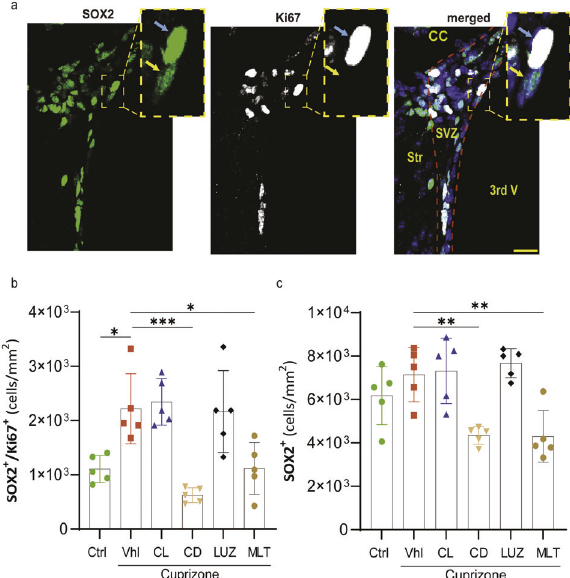
Fig. 4 Quanti fi cation of NSPC responses to demyelination and treatment in the SVZ. a Fluorescent staining of the NSPC marker SOX2, the proliferation marker Ki67, and DAPI. The blue arrow indicates proliferative SOX2, and yellow shows quiescent NSPCs. b Quanti fi cation of the number of proliferative NSPCs (SOX2 + / Ki67 + ). c Quanti fi cation of the number of NSPCs (SOX2 + ), which included both quiescent and proliferative NSPCs. All quanti fi cations were performed in the SVZ region on 25 μ m-thick sections ( n = 5 mice/group; 3 slides per mouse). Signi fi cance is indicated by ∗ p < 0.05, ∗∗ p < 0.01, and ∗∗∗ p < 0.001. Scale bars, 20 μ